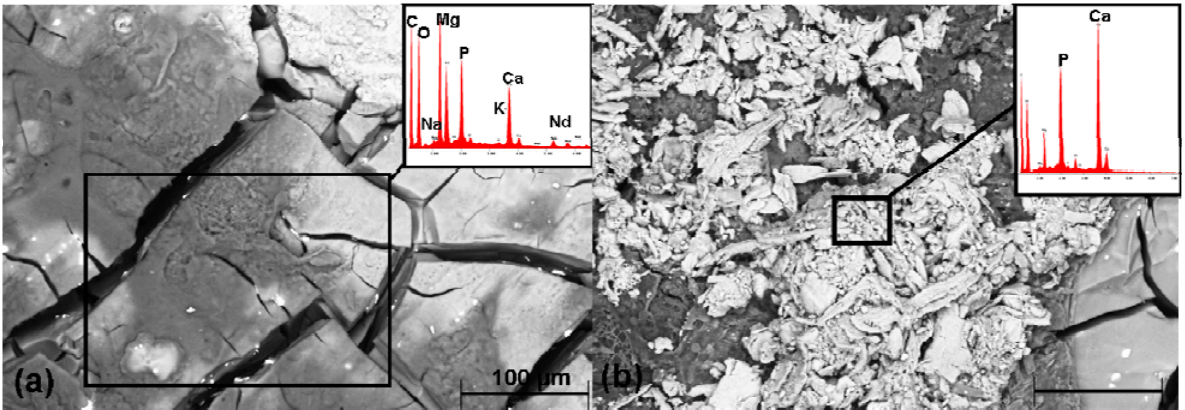
Figure 8. SEM images of the pin’s surface using a pin following 26 weeks implantation prior to the hydrofluoric acid treatment and the EDX analysis of the individual elements in the marked regions: ( a ) clump-like structures; ( b ) crystalline structures, verification of Ca and P on the pin’s surface. Each of the boxes mark the regions selected for the EDX